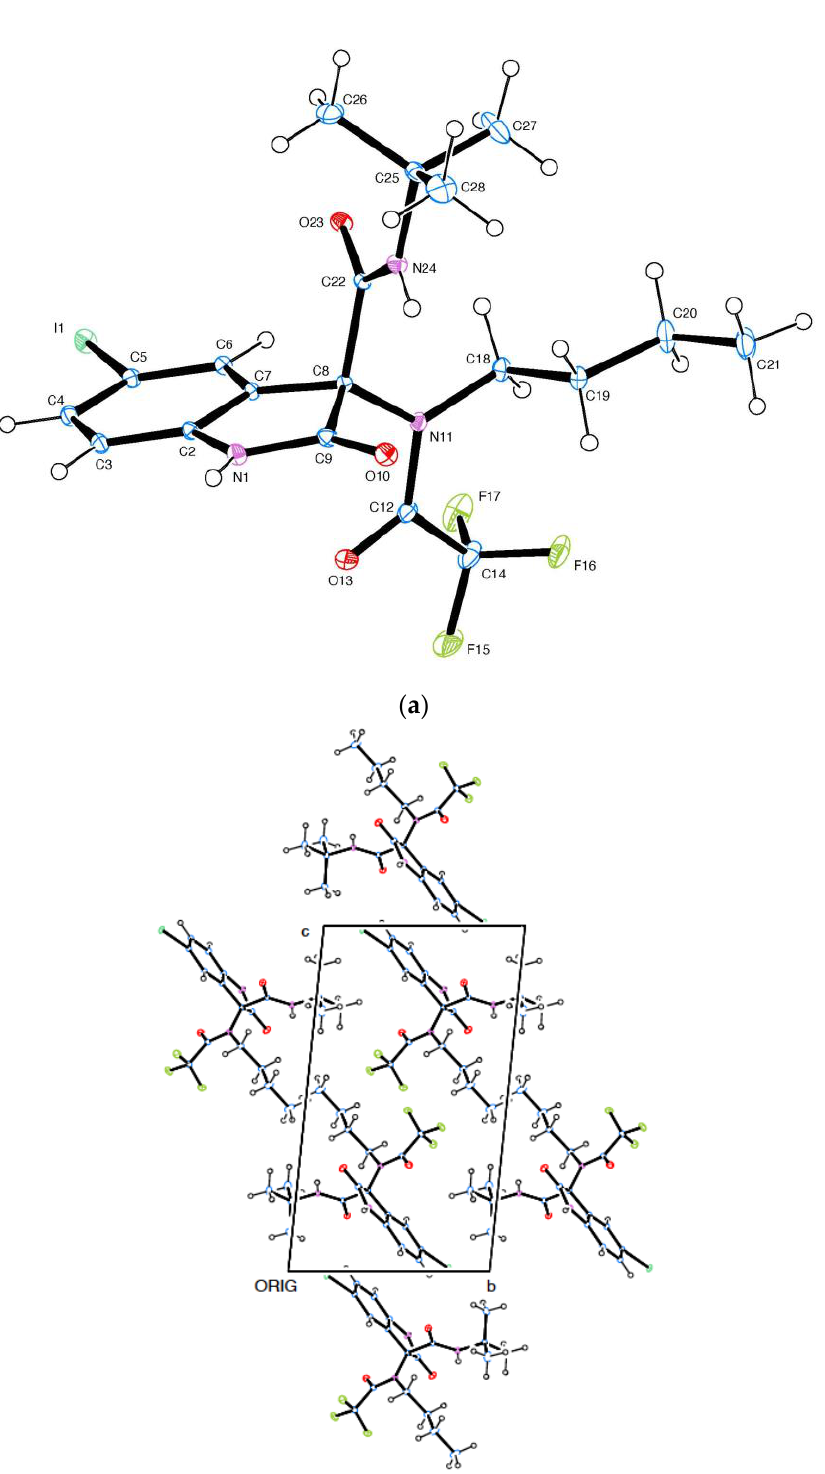
Figure 3. ( a ) ORTEP diagram of compound 17 , obtained by single crystal X-ray diffraction, showing the molecular conformation and numbering. ( b ) Crystal packing of 17 .